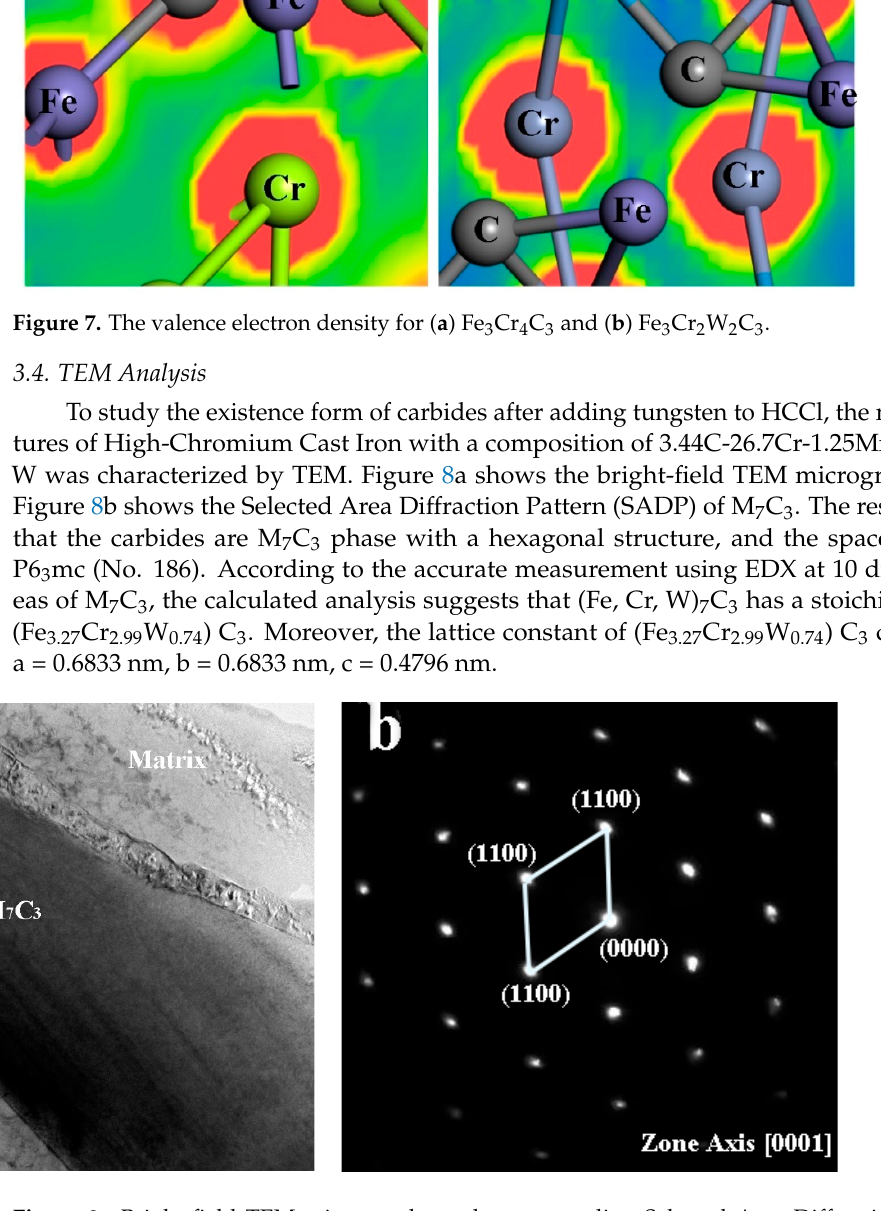
Figure 8. Bright-field TEM micrographs and corresponding Selected Area Diffraction Patterns (SADPs): ( a ) bright-field TEM micrographs; ( b ) corresponding SADPs of M 7 C 3 .